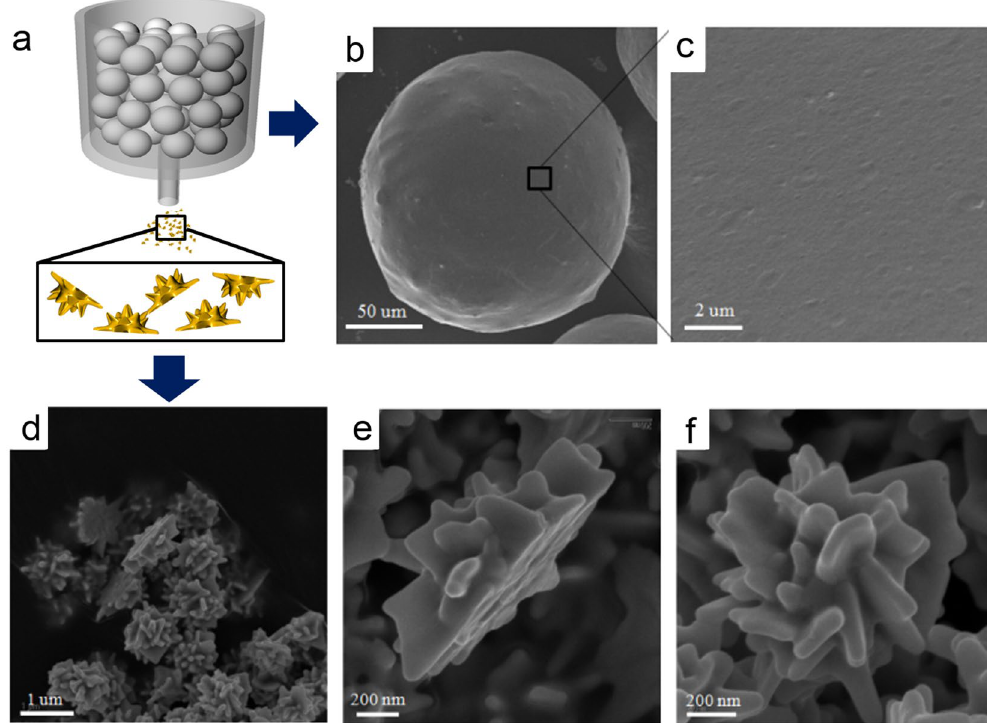
Figure 1. Cleavage from the beads and half-planar particles. ( a ) Illustration of beads and NPs, ( b ) SEM image of bead, ( c ) high magnification SEM image of bead, ( d ) low magnification SEM image of asymmetric nanorose, ( e ) side view of nanorose ( f ) top view of nanorose